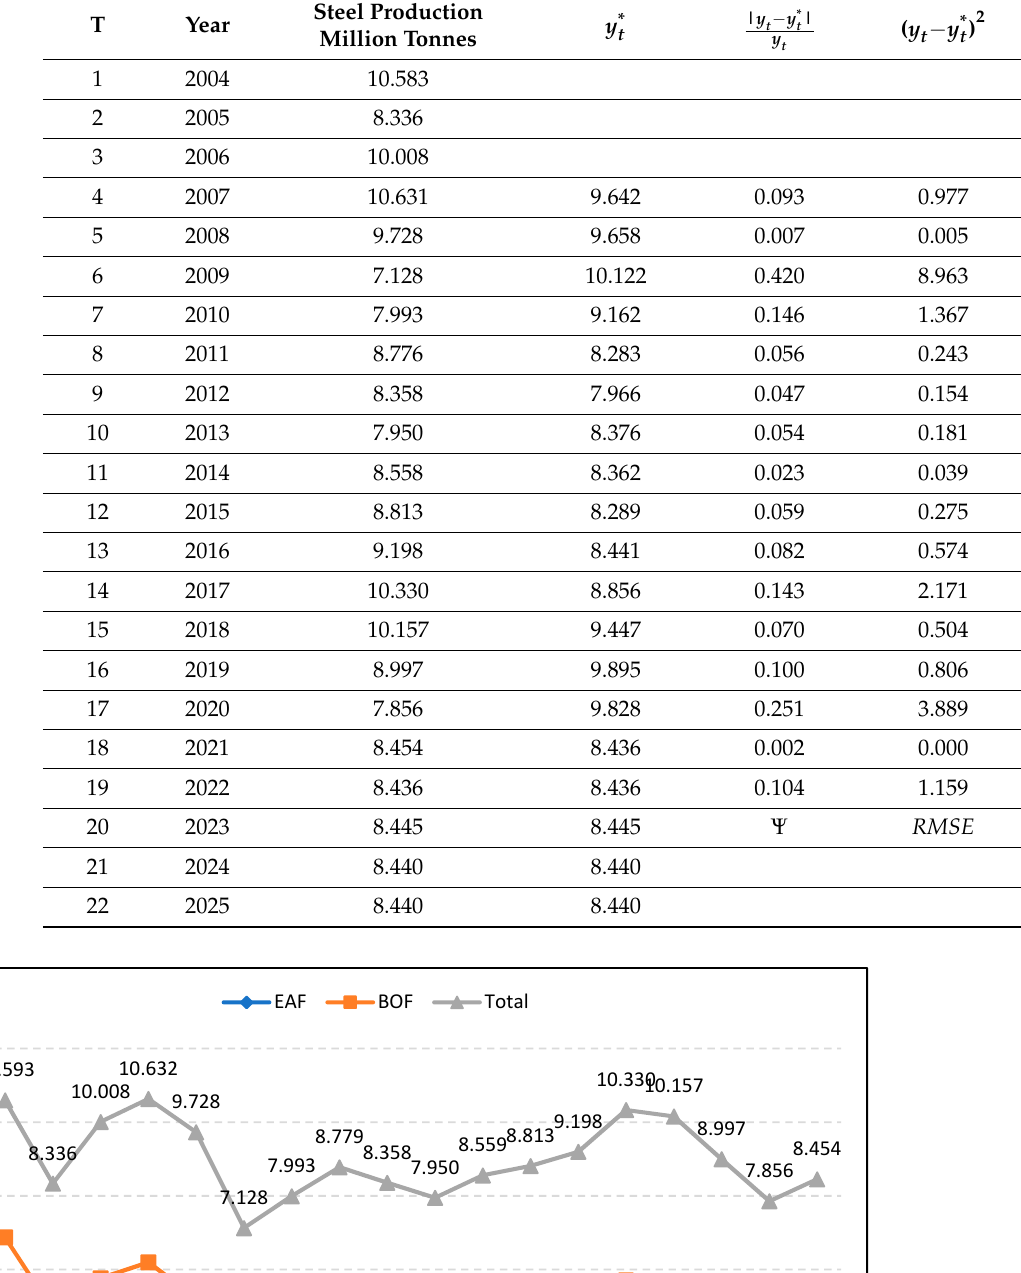
Table 1. Forecasts of steel production in Poland.